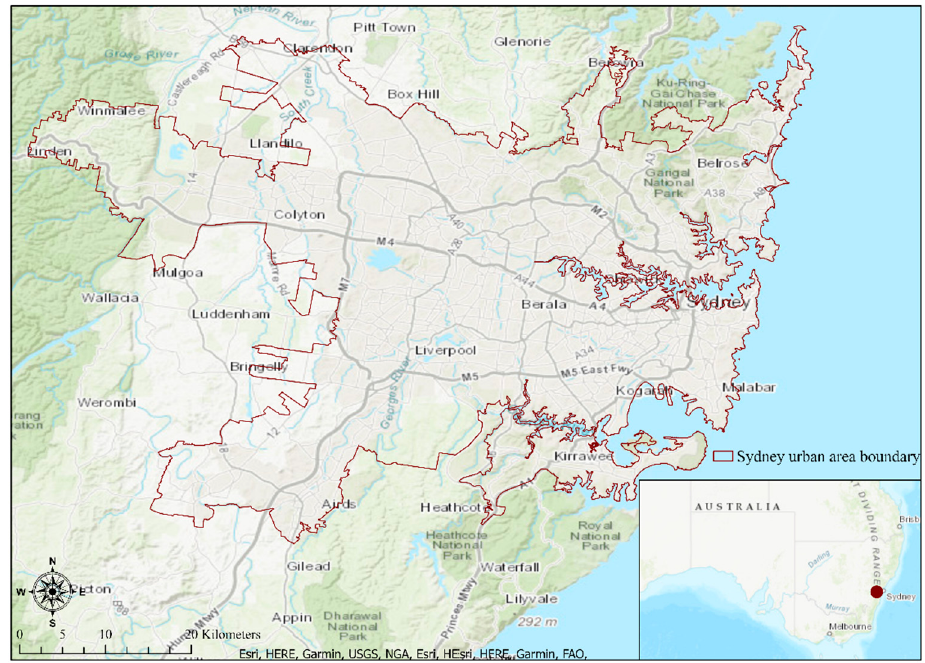
Figure 1. Map of Sydney urban area represented by the urban center and locality boundary (demarcated by the red line).